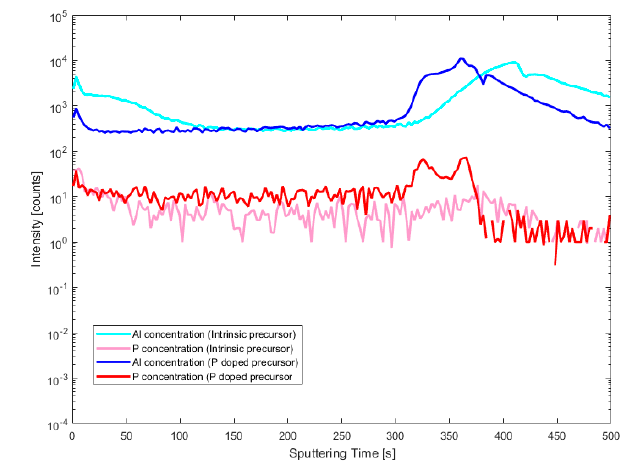
Figure 2. TF-SIMS measurement of doped AIC